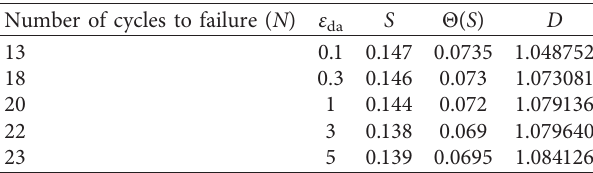
Table 4: Changes in D .